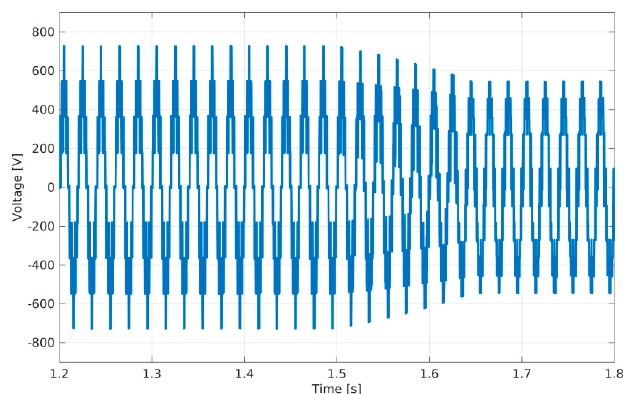
Figure 10. Phase voltage applied to winding 1 with a voltage sag of 30%.